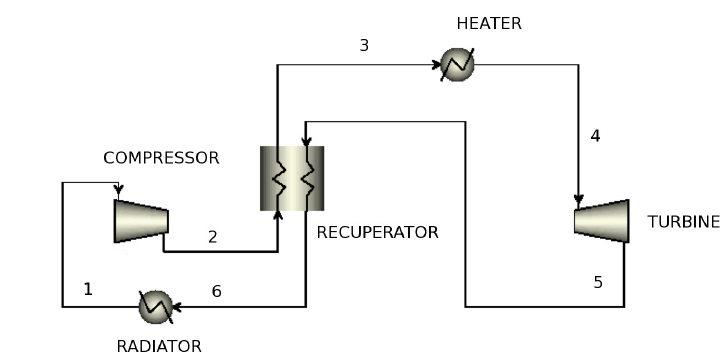
Figure 1. Simplified plant scheme of the considered